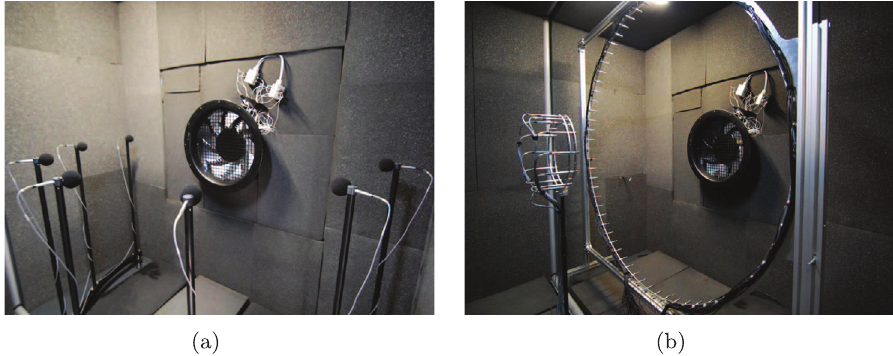
Figure 3. (a) Conventional far- fi eld noise measurement setup for axial fans and (b) microphone array measurement